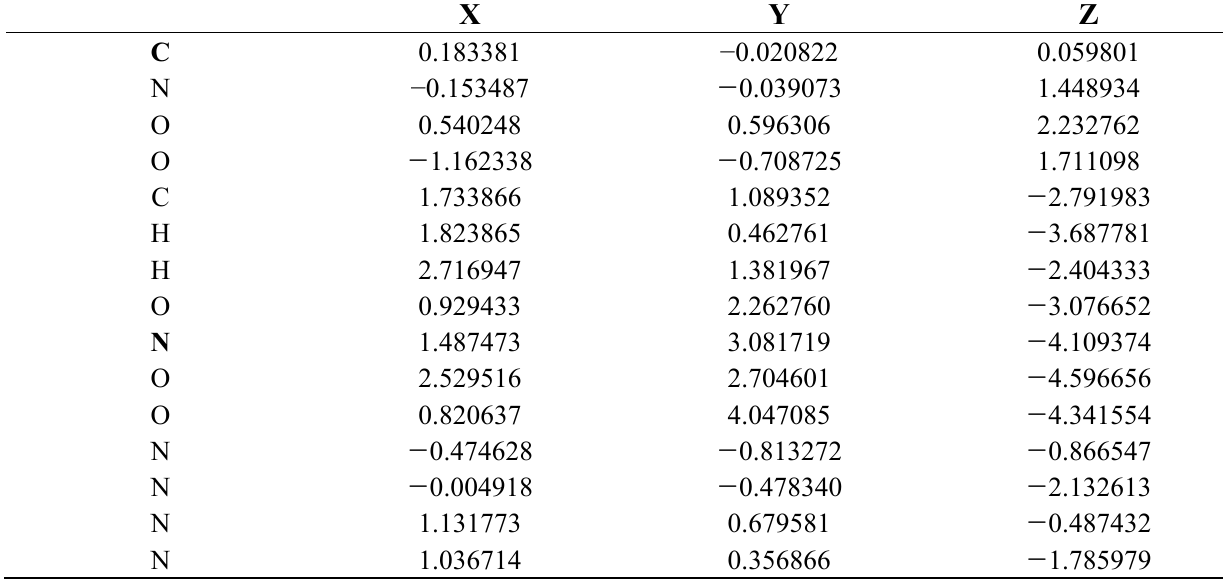
Table 4. Cartesian coordinates of the optimized structure 4